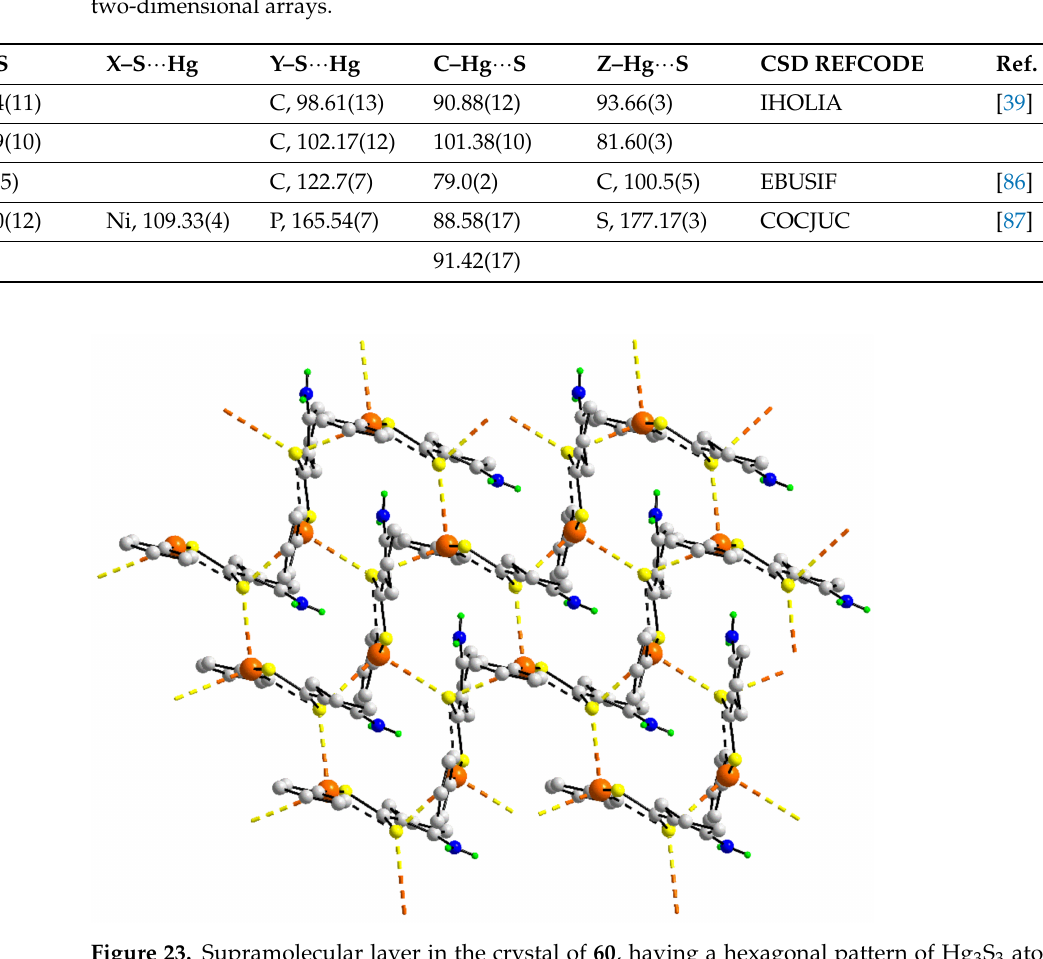
Table 5. Summary of geometric parameters (Å, ◦ ) for 60 – 62 , each featuring Hg ··· S contacts within two-dimensional arrays.